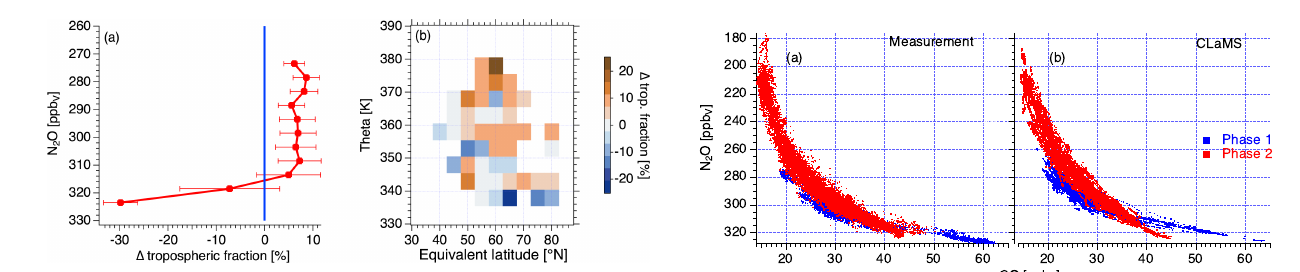
Figure 9. N 2 O–CO scatter plot measured by the TRIHOP instru- ment (a) and CLaMS model output (b) . Phase 1 coloured in blue, phase 2 coloured in red. The model output is available along the flight track with a time resolution of